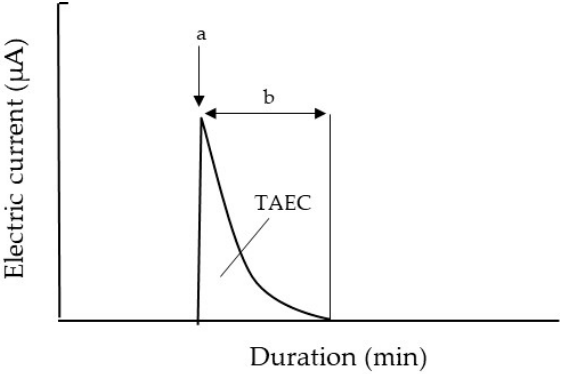
Figure 4. Typical profile of electric current generated by an adult housefly placed on the GIP of the negatively charged EFP. (a) Electric current produced by the fly at the time of attraction to the N-PIP. (b) The electric current produced during subsequent confinement to the N-PIP. The total amount of electricity released from the fly was calculated as the total amount of electric current (TAEC) (µA min) generated by the fly, according to the area bounded by the x-axis and the plotted curve of the generated current.